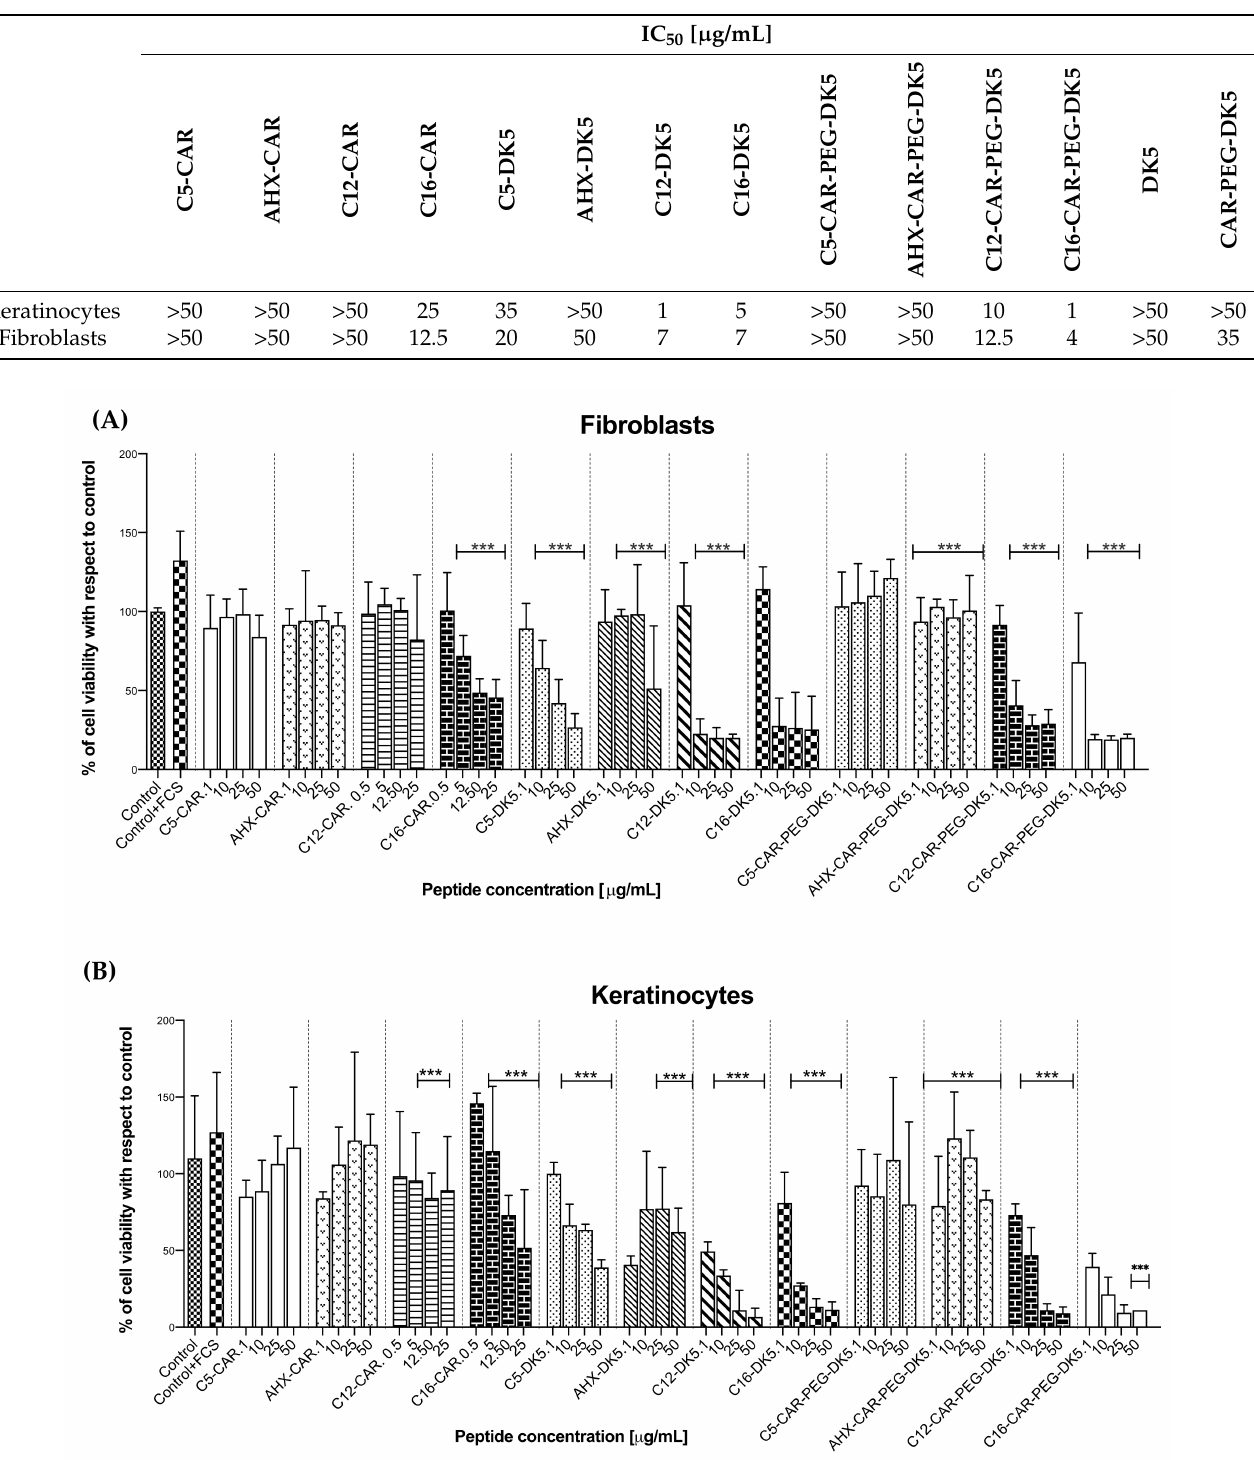
Figure 2. Evaluation of the cytotoxic effect of the tested compounds on human primary fibroblasts ( A ) and transformed cell line of human keratinocytes ( B ).The data cover the results of MTT colorimetric assay and express the percentage of cell viability of the certain probes with respect to control probe (untreated cells, incubated in serum-free DMEM). Additional positive control corresponds to cells incubated in the presence of 10% of FCS in DMEM. All data were obtained from three independent experiments performed in triplicates. Results are expressed with their standard deviation (error bars). *** p < 0.001 vs.